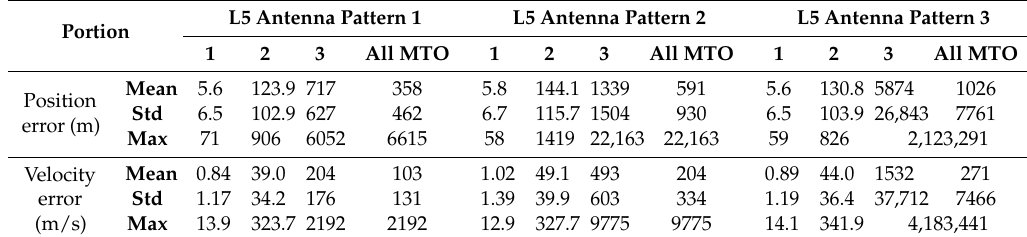
Figure 29. Single-point least squares estimation error for the assumed MTO. Table 7. Statistics of the single-point least squares estimation error.